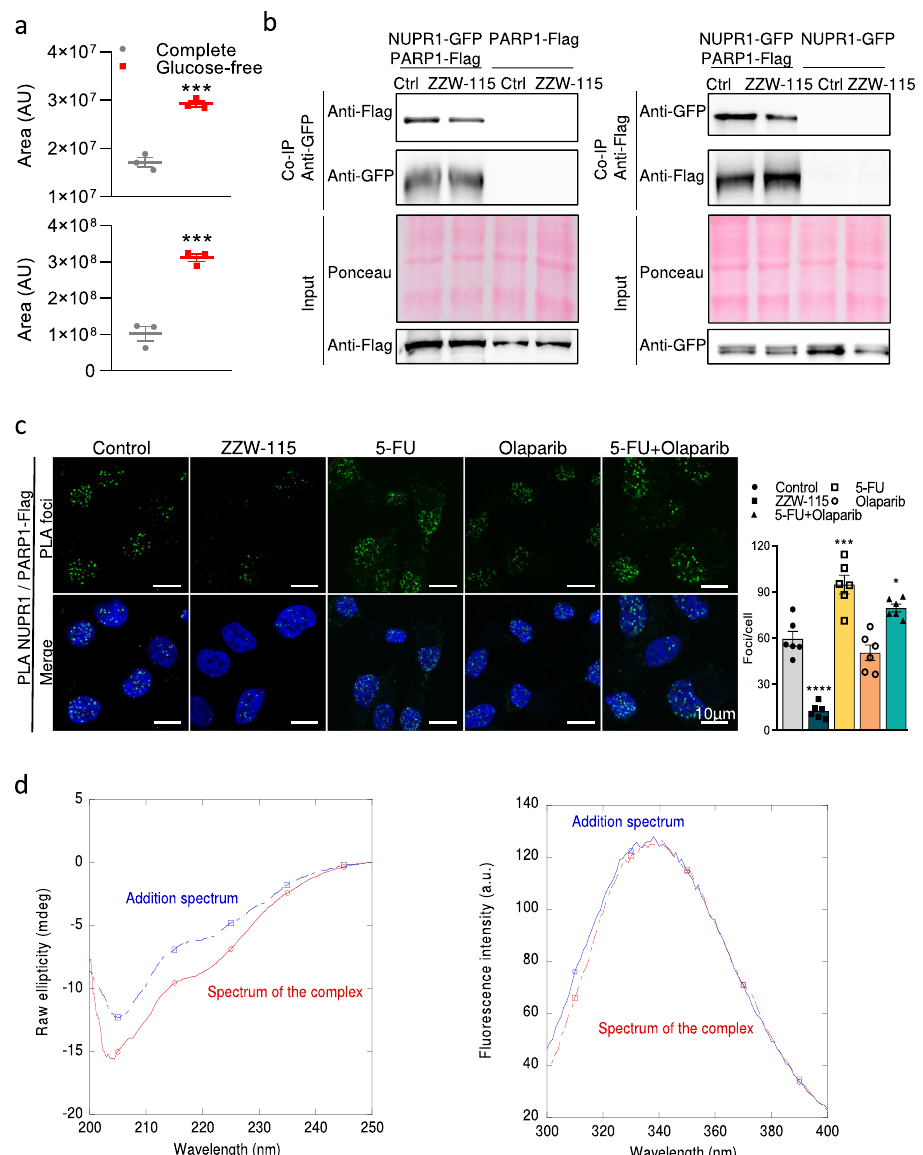
Fig. 1 NUPR1 interacted with PARP1 in cellulo and in vitro. a Mean of peak area values measurement after immunoprecipitation with anti-FLAG or anti- GFP agarose beads and LC-MS/MS proteomic analysis in MiaPaCa-2 cells transfected with NUPR1-Flag plasmid (up) or NUPR1-GFP (down) ( n = 3). b Co- IP assays showing interactions of NUPR1-GFP with PARP1-Flag in MiaPaCa-2 cells transfected with PARP1-Flag and NUPR1-GFP plasmids. Anti-FLAG agarose beads (right) or anti-GFP agarose beads (left) were used ( n = 3). c PLA was performed in MiaPaCa-2 cells in the presence or in the absence of ZZW-115 at 1.5 µ M, 5-FU at 10 µ M, olaparib at 25 µ M or 5-FU + olaparib for 24 h. Cells were transfected with the plasmid expressing PARP1-Flag. Mouse anti-Flag and rabbit anti-NUPR1 antibodies were used. A representative experiment is shown ( n = 6). ImageJ was used to count the number of green dots. Data represent mean ± SEM. One-way ANOVA, Dunnett correction; * P < 0.05; ** P < 0.01; *** P < 0.001; **** P < 0.001. d Monitoring binding by spectroscopic techniques: (Left) Far-UV CD spectrum of the mixture of PARP1 and NUPR1 and that obtained by the addition of the spectra of the isolated macromolecules. (Right) Fluorescence spectrum of the same mixture of PARP1 and NUPR1 and that obtained by the addition of the spectra of the isolated